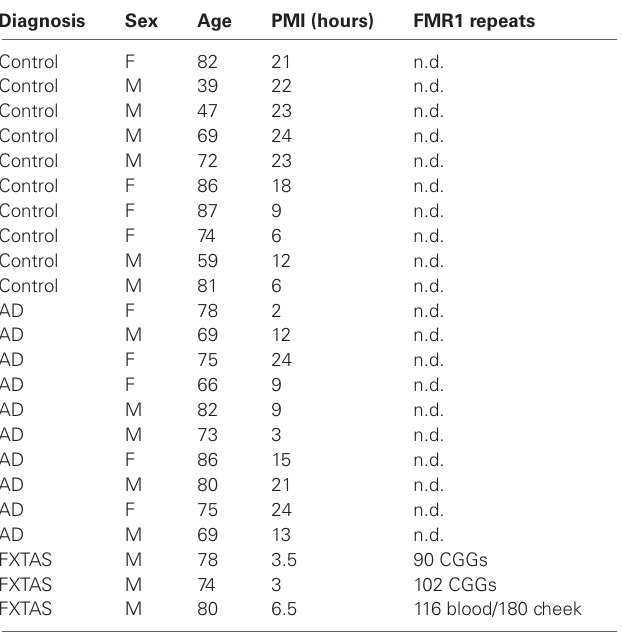
Table 1 | Patient donor